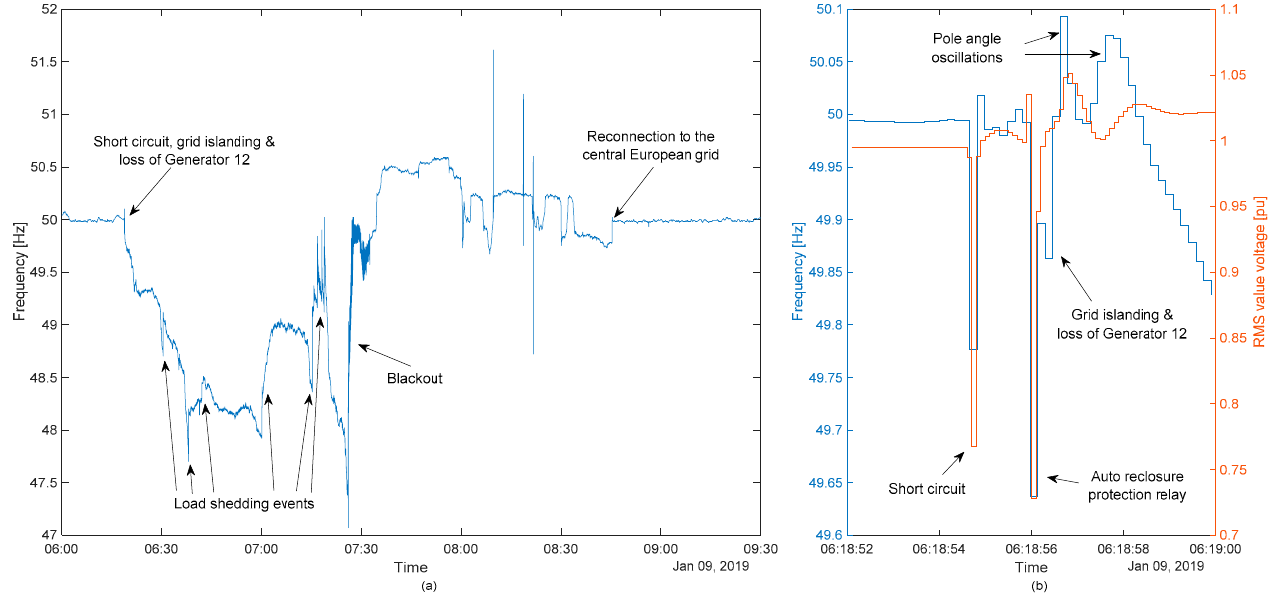
Figure 2. ( a ) Grid frequency measured at the Flensburg power station on 9 January 2019. ( b ) Grid frequency and root mean square (RMS) value of the grid voltage measured at the Wind Energy Technology Institute (WETI) during the initial event on 9 January 2019.